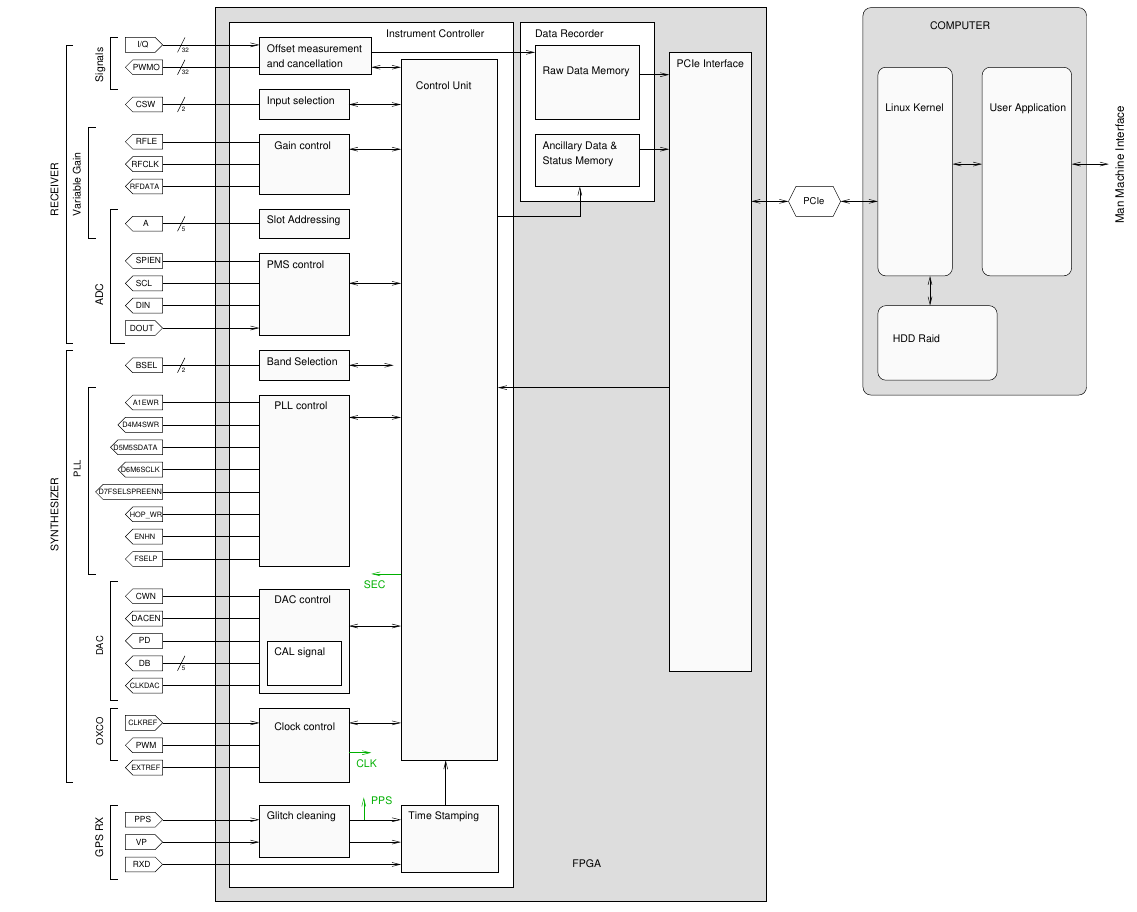
Figure 4. Block diagram of the control and recording system of